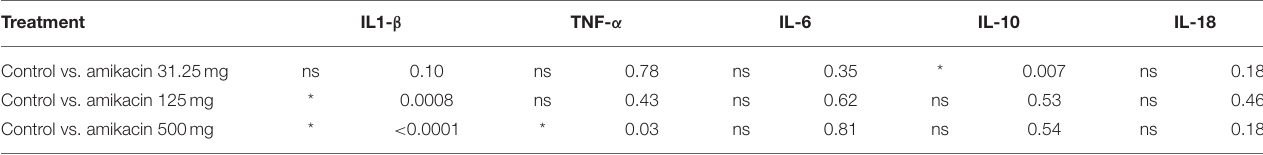
TABLE 3 | Statistical analysis of the cytokine levels in the synovial fluid following amikacin treatment at various doses or the control (lactated Ringer’s solution). Treatment IL1-